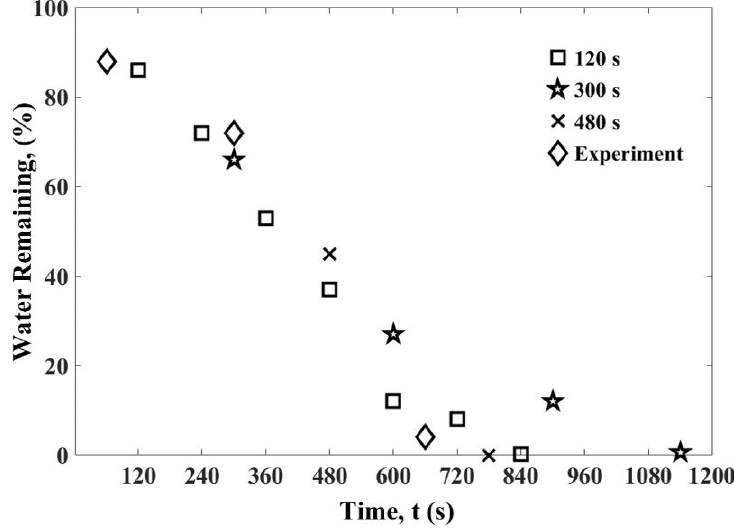
Figure 8. Comparison of effect of time-steps for a rectangular composite sample being dried at P in = 30% . Total sample weight = 45 g.